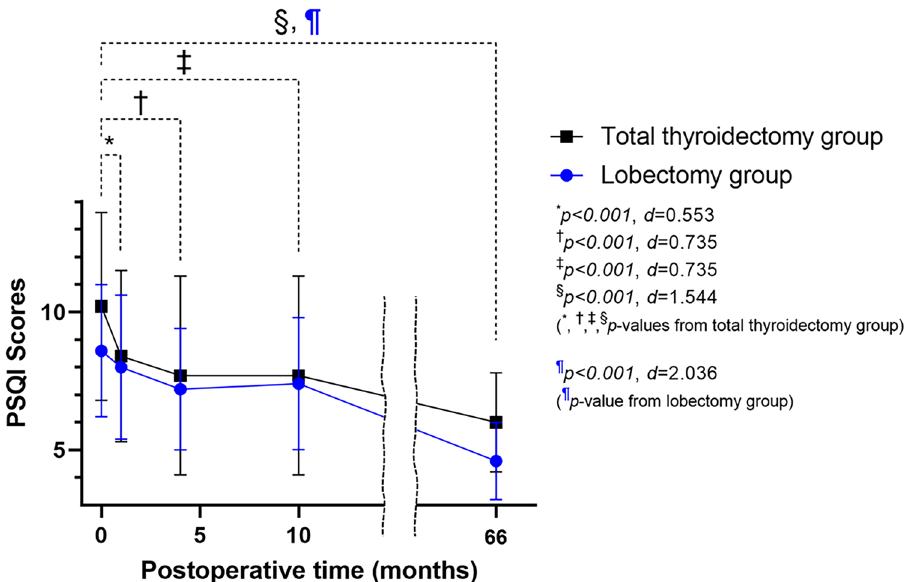
Figure 2. Comparison of PSQI scores in patients with thyroid cancer who underwent lobectomy vs total thyroidectomy. Error bars indicate ± standard deviations of the mean. PSQI Pittsburgh sleep quality index. d indicates Cohen’s